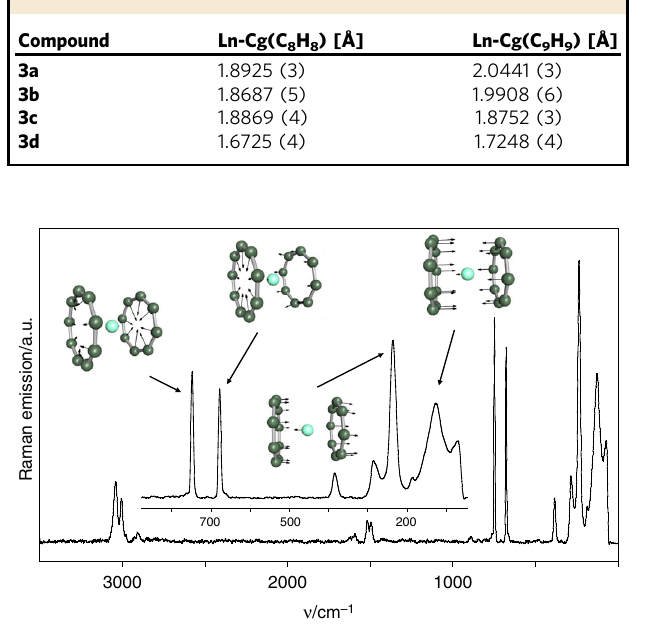
Fig. 6 Raman-spectroscopic analysis. FT-Raman spectrum of [( η 9 -C 9 H 9 )Sm ( η 8 -C 8 H 8 )] 3b . The motion vectors of four prominent bands are inserted. Hydrogen atoms and their motion vectors are omitted for clarity